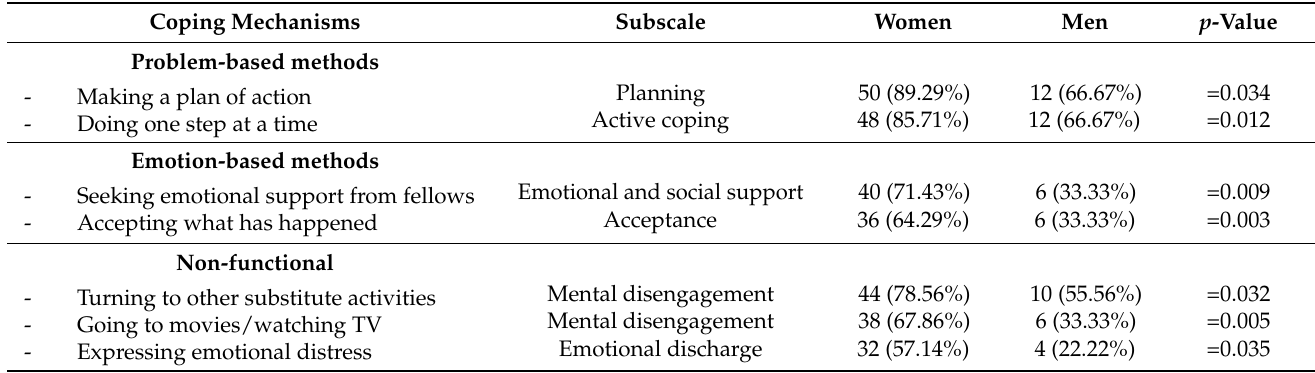
Table 12. Gender-dependent coping